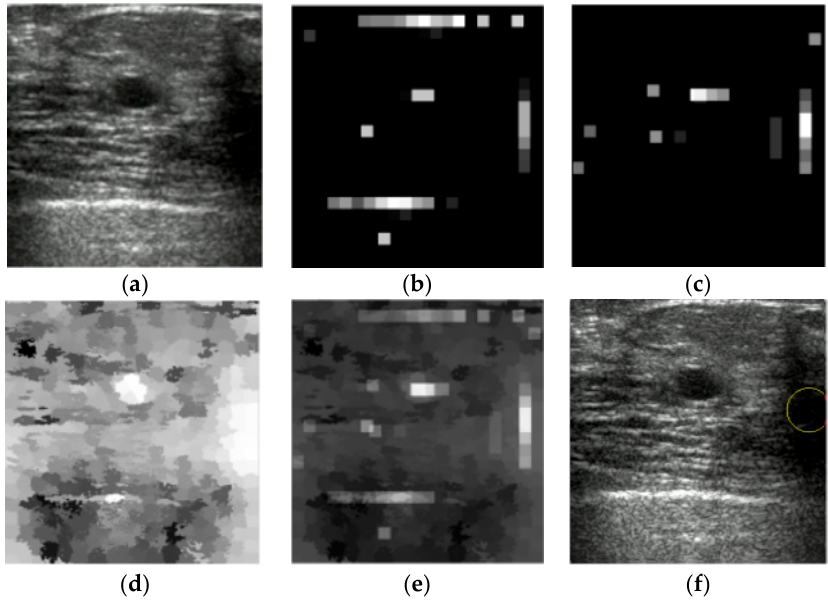
Figure 14. An example of wrong localization by the proposed method. ( a ) Original image, ( b ) intensity saliency map, ( c ) blackness ratio saliency map, ( d ) superpixel saliency map, ( e ) combined saliency map of three features, and ( f ) localization results.